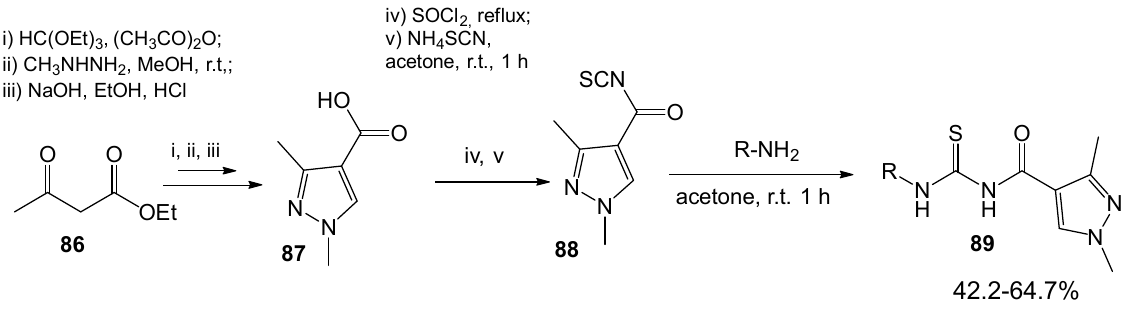
Fig. 24. Approaches to the synthesis of 1-methyl- N -(arylcarbamothioyl)-1 H -pyrazole-4-carboxamides